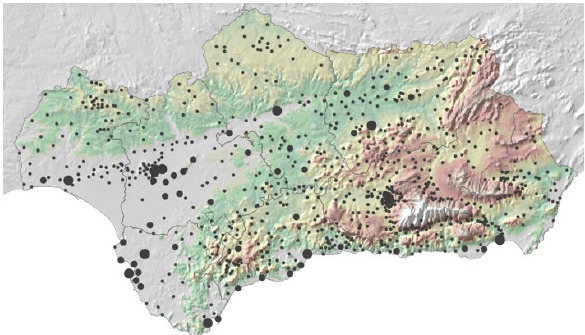
Figure 3. Urban settlements in Andalusia categorised by population ranges (<20.000, 20.000<100.000, <100.000) together with a topography map based on shadows and